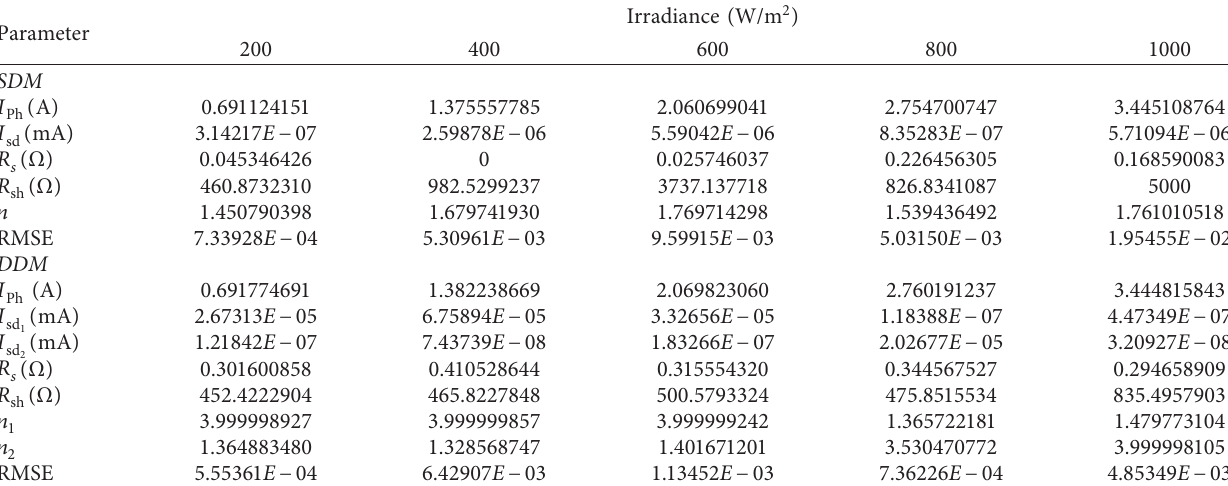
Table 11: Parameter estimates by MWOA for SM55 at different irradiances with a temperature of 25 ° C. Parameter